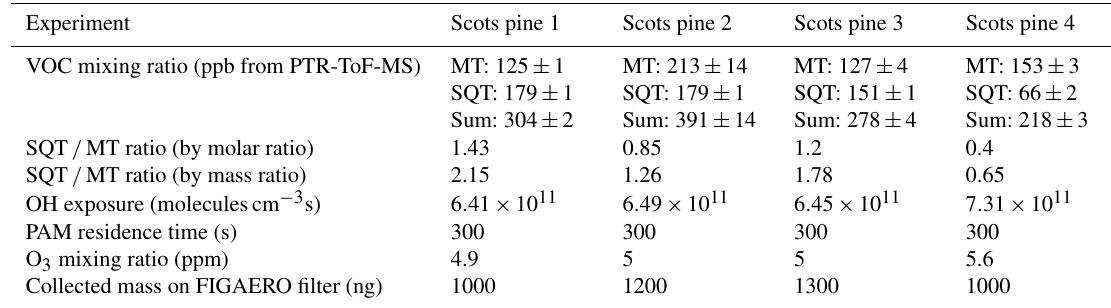
Table 1. List of different Scots pine experiments with corresponding PAM 1 reactor conditions. Monoterpenes are referred to as MT and sesquiterpenes as SQT. Collected mass is estimated from SMPS data assuming a particle density of 1.3gcm − 3 .